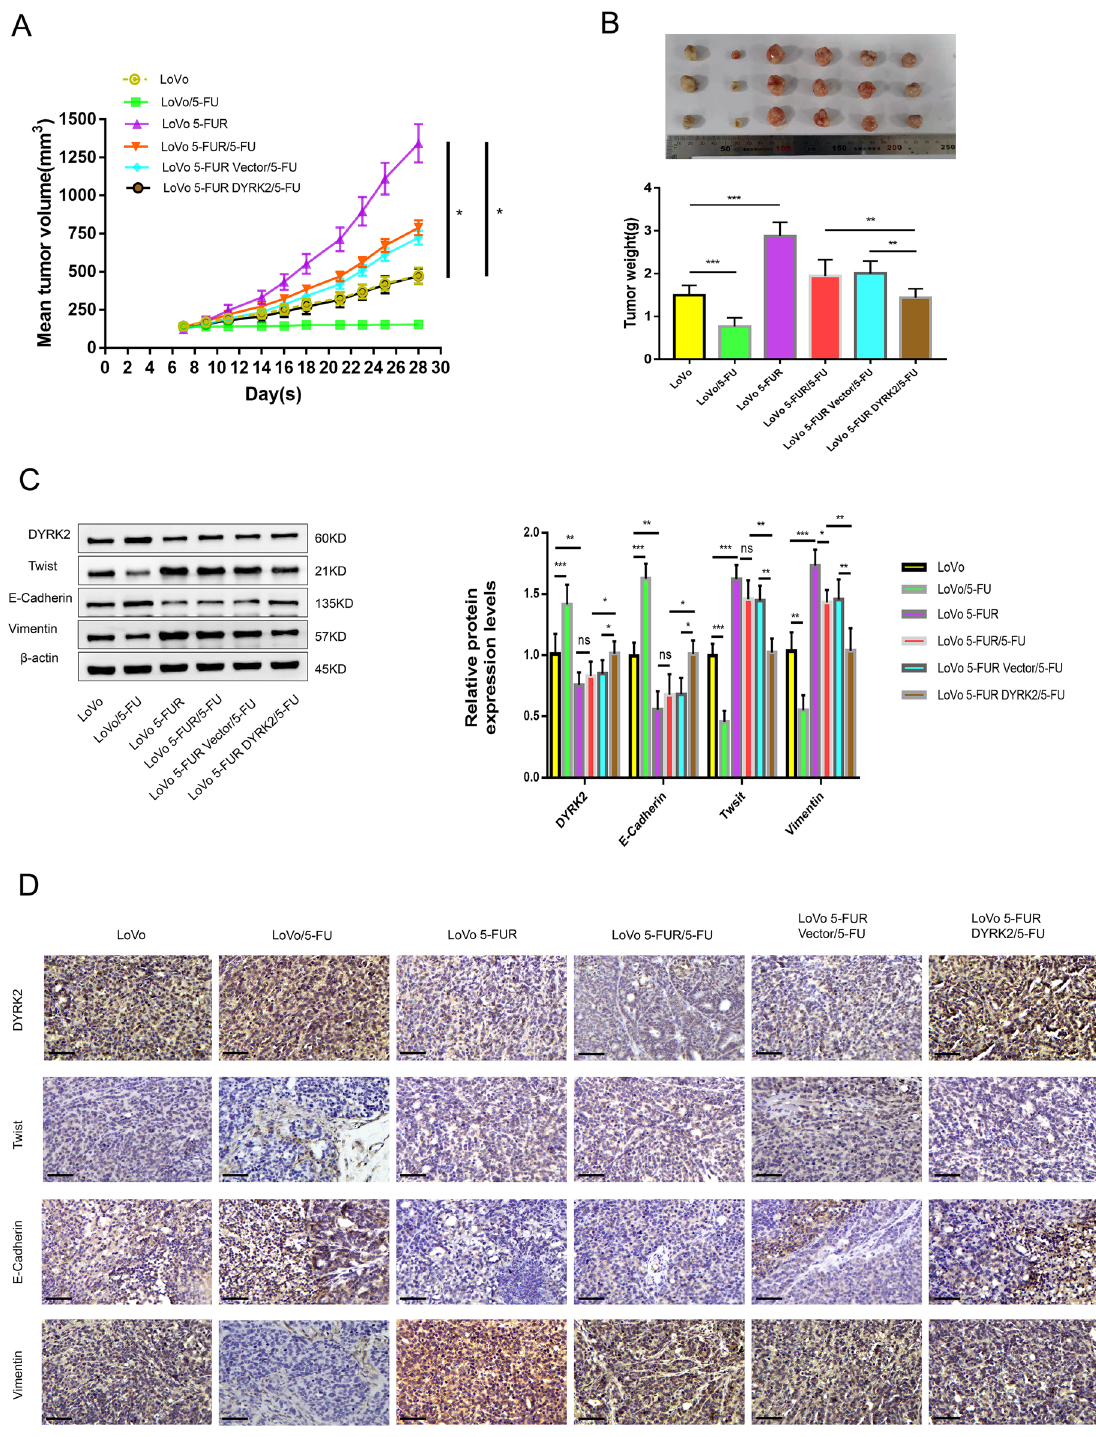
Figure 7. DYRK2 inhibits the in vivo growth of CRC tumors via targeting Twist. ( A ) Changes in subcutaneously implanted tumor volume over time. ( B ) Tumor weight values at the end of the study period in the indicated groups. ( C ) DYRK2, Twist, E-Cadherin, and Vimentin expression were assessed via Western blotting. ( D ) IHC staining was used to detect DYRK2, Twist, E-cadherin, and Vimentin expression in the indicated